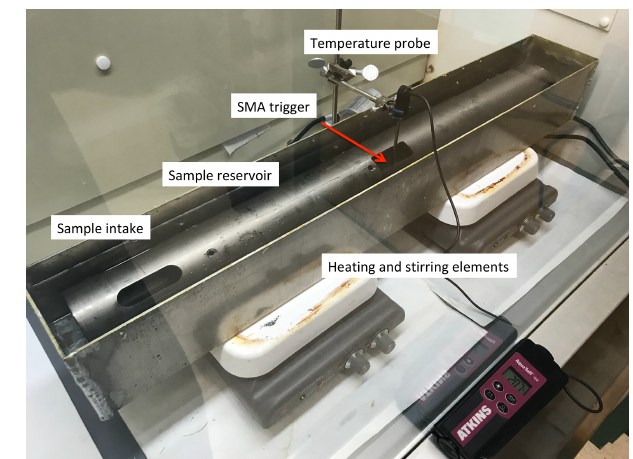
Figure 2. Tests of trigger mechanisms were conducted in a cus- tom bath of canola oil within a chemical hood. The bath holds one 35.5-inch-long (0.90m) MTFS module, two magnetic stir bars, and a temperature sensor. The temperature sensor is placed within mil- limeters of the shape metal alloy (SMA) to document the temper- ature at which the trigger is activated. Two heaters with magnetic stirrers keep the oil bath well mixed, heating the bath to 190 ◦ C in 1h.